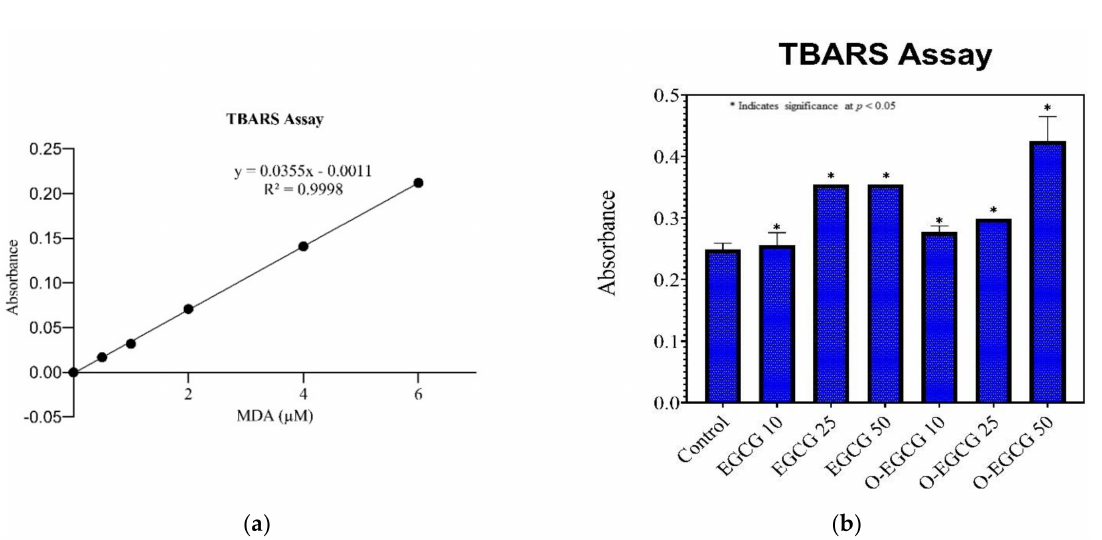
Figure 4. ( a ) Calibration curve of 1,1,3,3-Tetramethoxypropane. ( b ) Levels of TBARS formed by EGCG and O-EGCG. (* indicates significance at p <